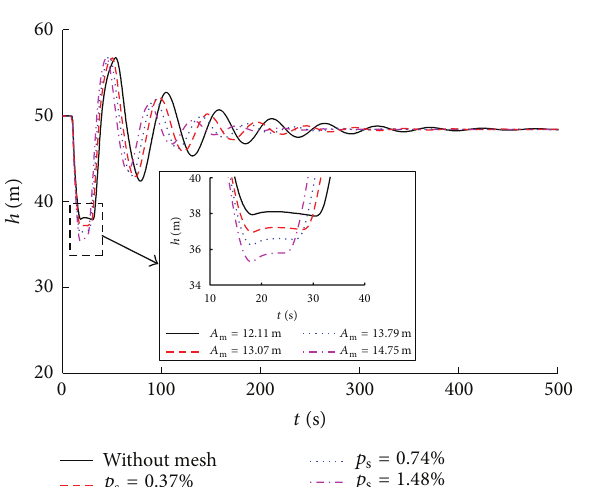
Figure 15: Transient intensions for various reinforcement